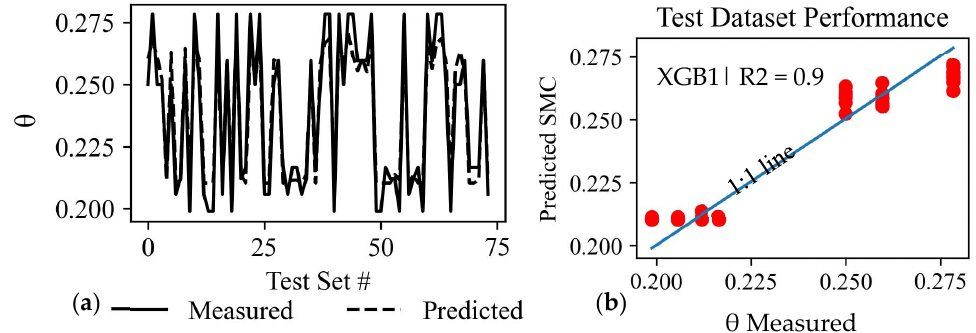
Figure 14. XGB1 soil moisture content evaluation metrics: measured ( θ ) vs. predicted ( θ ’) for the test samples. ( a ) Line plot. ( b ) Scatter plot.